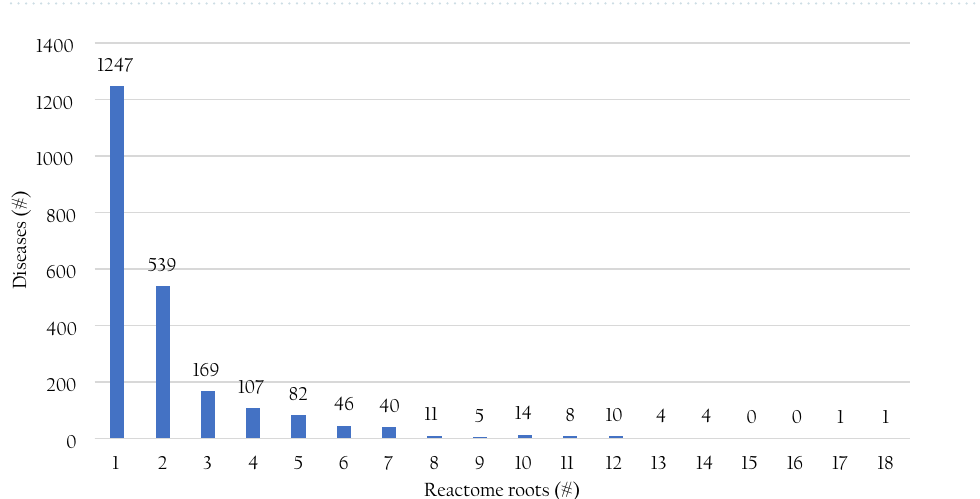
Figure 5. An example of a polygenic disease associated with many Reactome pathways (Polygenic disease-Type B in Fig. 3). The blue dot represents the disease (Leigh syndrome with leukodystrophy) associated to 12 different enzymes (in green enzymes that are part of the mitochondrial complex 1 and in yellow other enzymes). Red nodes represent the Reactome leaf pathways associated with the enzymes.